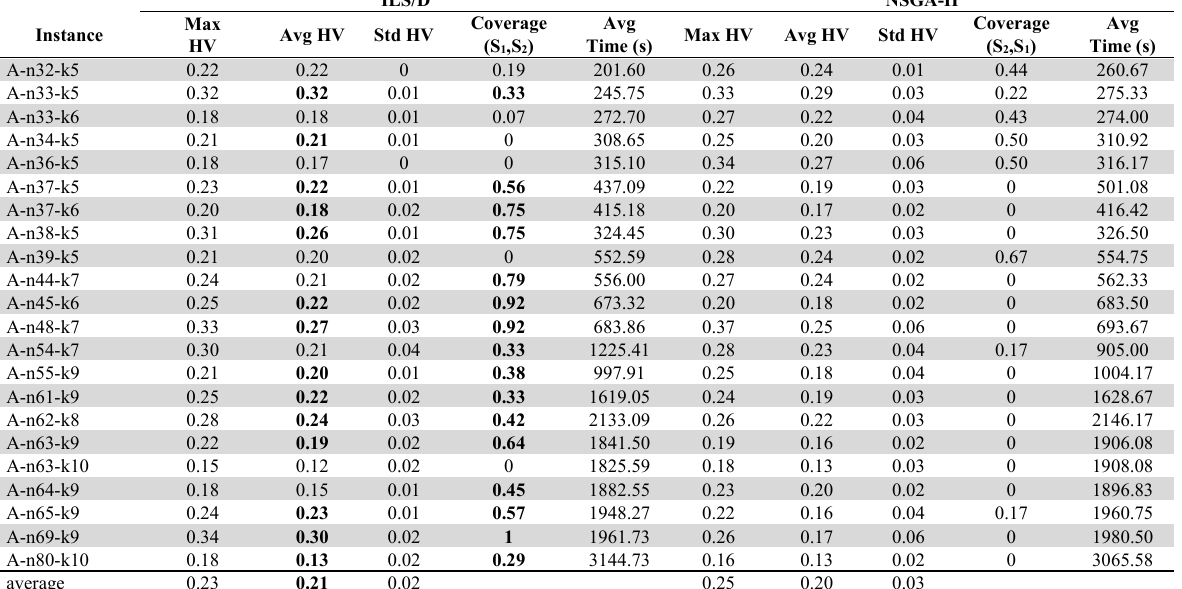
The HV and coverage obtained values for both the ILS/D and NSGA-II algorithms ILS/D NSGA-II Max Avg HV Std HV Instance HV